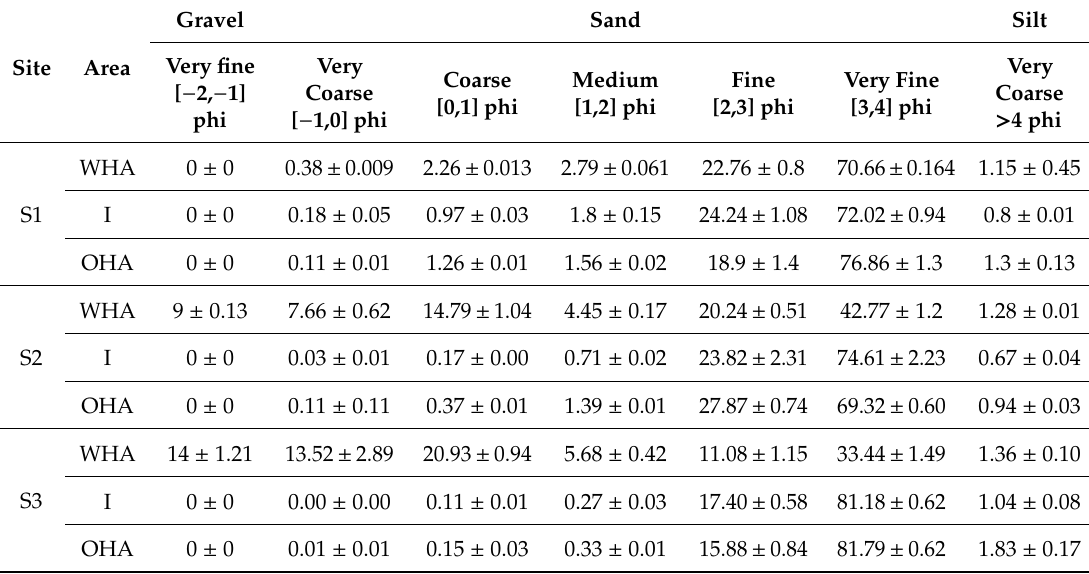
Table 2. Grain size of sediments collected on 13 December, 2017, classified according to the Udden–Wentworth [20,21], of each area in each study site. The average cumulative weight in percent in each class and the standard error are shown. WHA, area with hydrothermal activity; I, intermediate area; OHA, out of hydrothermal activity area.